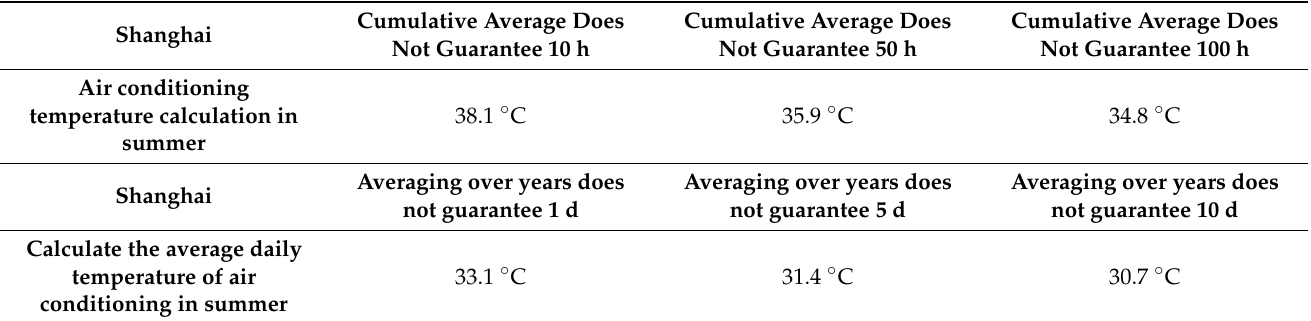
Table 11. Selection results in Shanghai region.